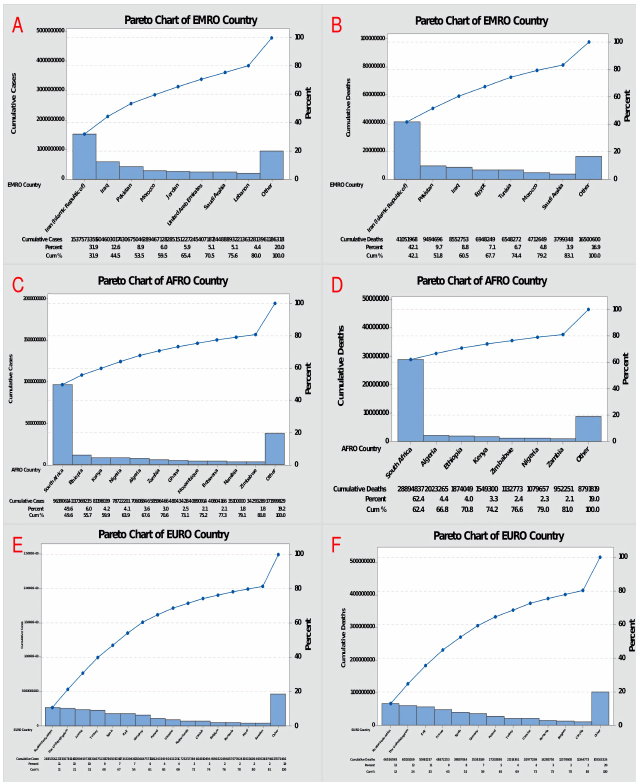
Figure 3. Pareto chart showing major countries in mortalities and morbidities from COVID-19 from EMRO (A and B), AFRO (C and D) , EURO (E and F).